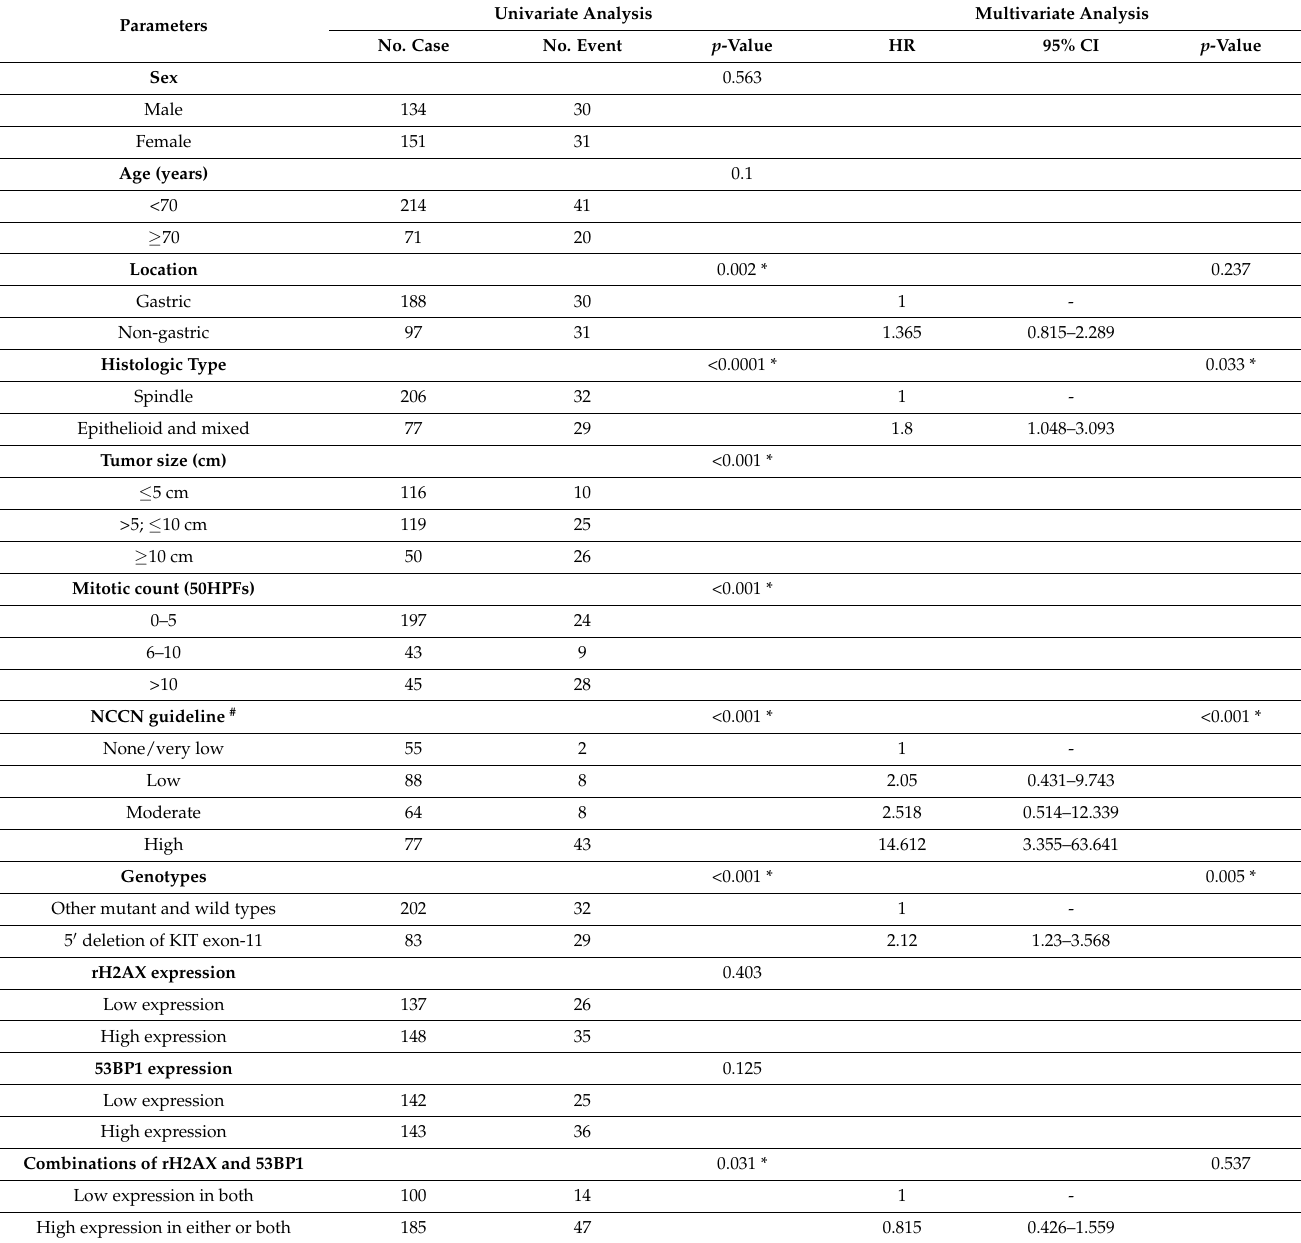
Table 4. Univariate and multivariate analyses for disease-free survival in 285 GISTs of the tissue microarray-based